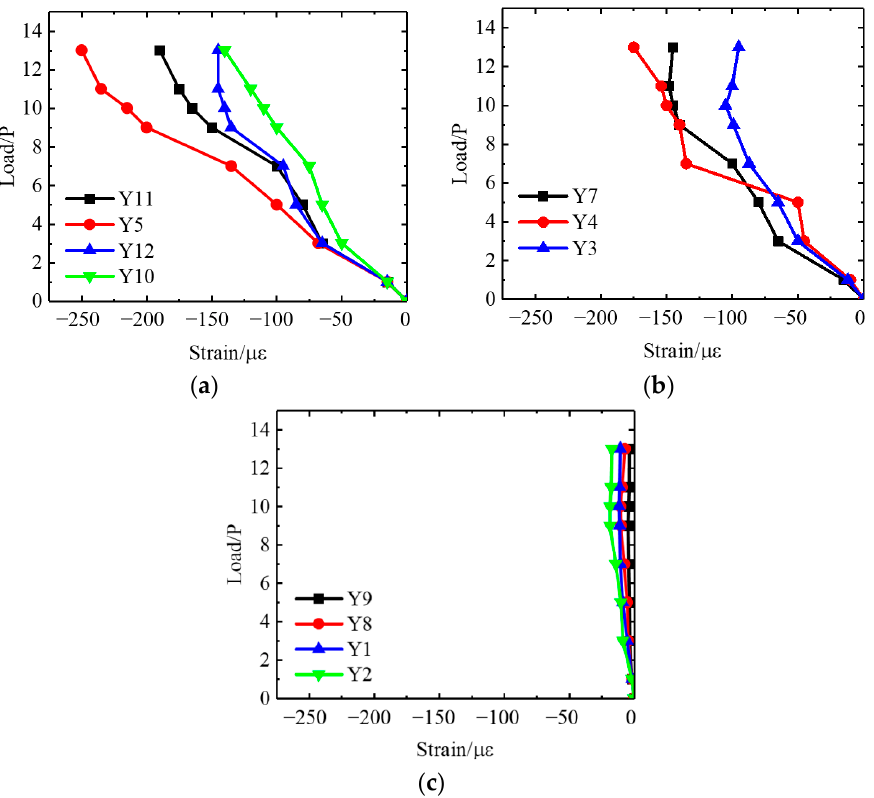
Figure 12. Overload and failure Strain gauge deformation test results: ( a ) back anchor surface; ( b ) middle anchor; ( c ) front anchor. ( b ) middle anchor; ( c ) front